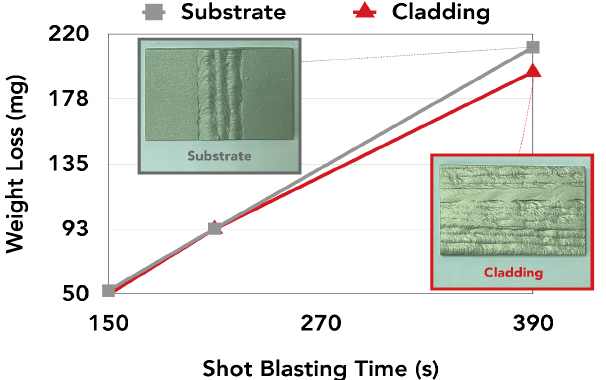
Figure 16. The results of the shot blasting wear tests.